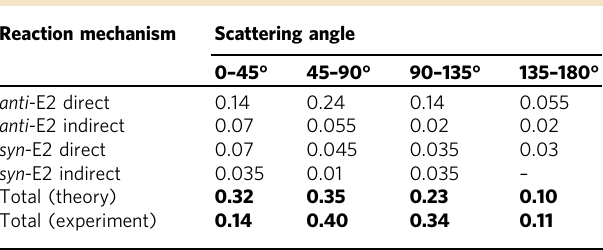
Table 2 Fraction of total reactive trajectories as a function of product ion scattering angle for the different anti-E2 and syn-E2 mechanisms Reaction